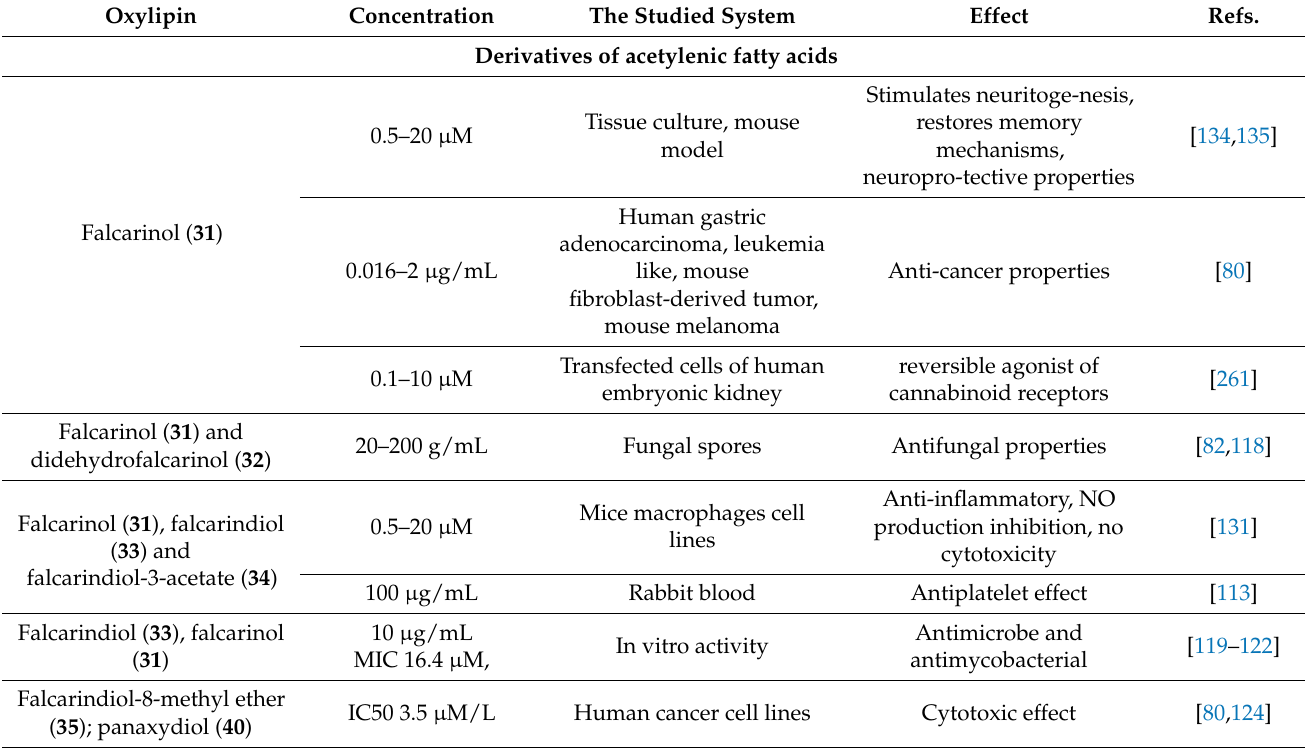
Table 1. Potential therapeutic and protective properties of plant